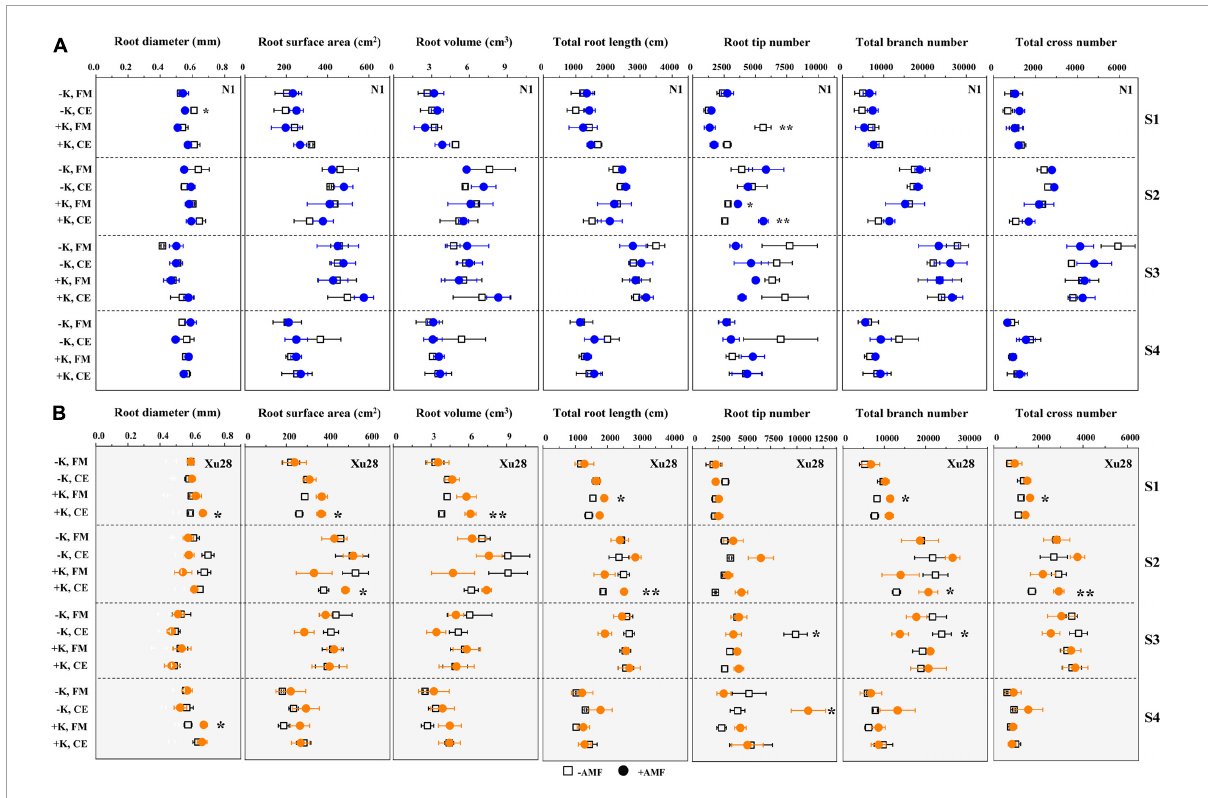
FIGURE4 The effects of potassium application and arbuscular mycorrhizal fungi (AMF) inoculation on the root morphology of N1 (A) and Xu28 (B) . For different groups, asterisks denote significant differences after AMF inoculation ( t -test; * P < 0.05; ** P < 0.01).